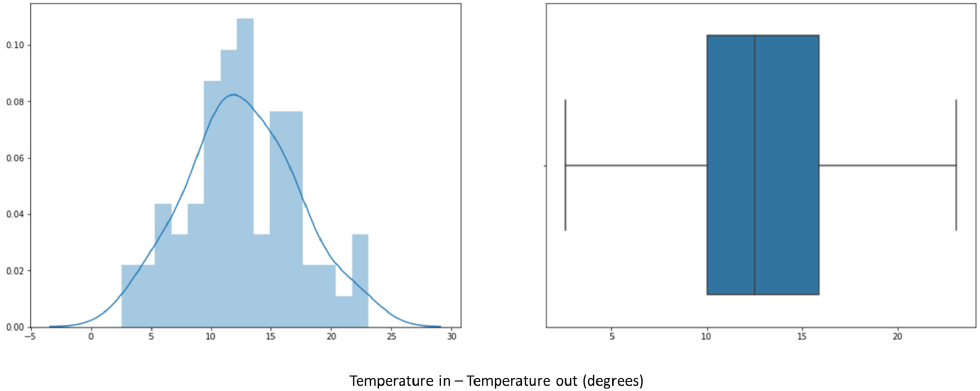
Figure 9. Temperature distribution during preheating for 200 batches of product: histogram ( left ); box plot ( right ).